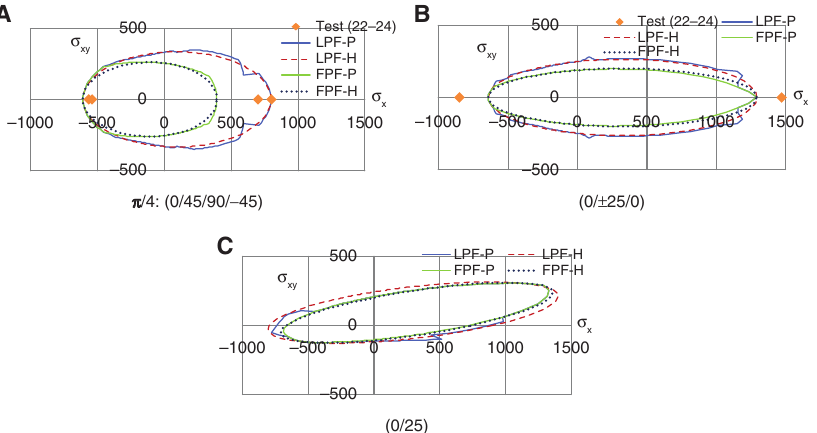
Figure 9: Sub-laminate first ply (FPF) and last ply (LPF) failure envelopes (in MPa): ply-by-ply (-P) vs. homogenized (-H) (A) quasi-isotropic, (B) balanced and orthotropic-like (C)